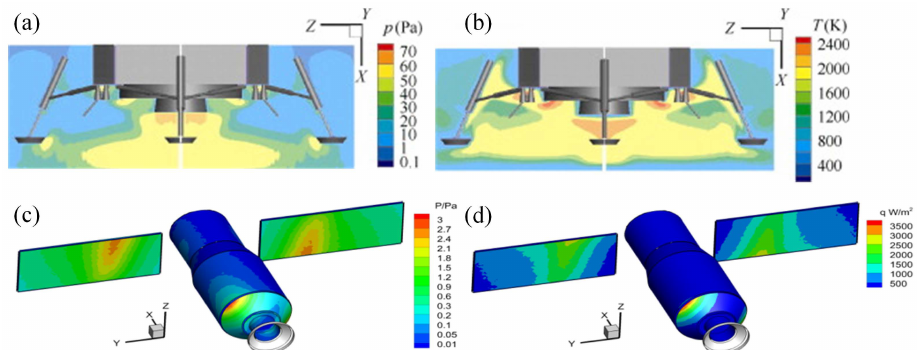
Figure 9. Simulation results of ( a ) pressure and ( b ) heat flux distribution during the Lunar probe descending [2]. Simulation results of ( c ) pressure and ( d ) heat flux loaded on the solar panels of passive vehicle during the rendezvous and docking. All the results are obtained by PWS.